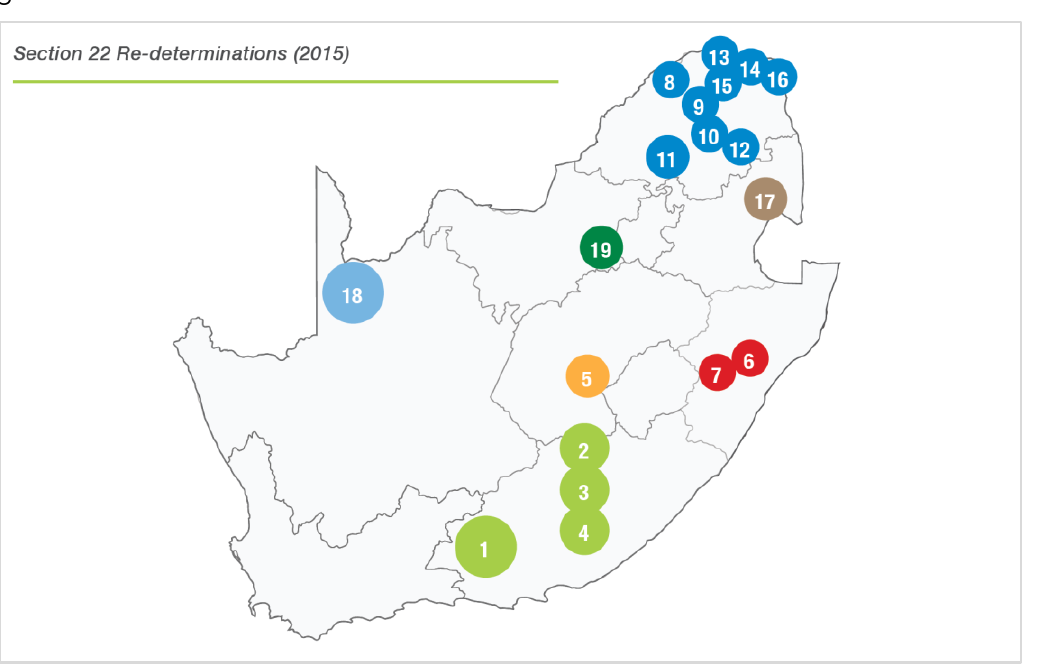
Figure 1: Outcomes of the 2015 re-determinations